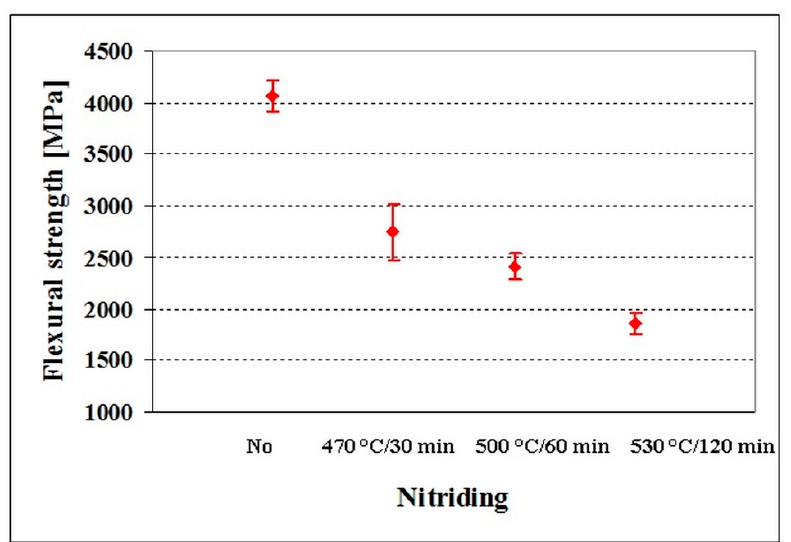
Figure 10. Flexural strength of non-nitrided and differently plasma nitrided specimens made of Vanadis 6 steel.